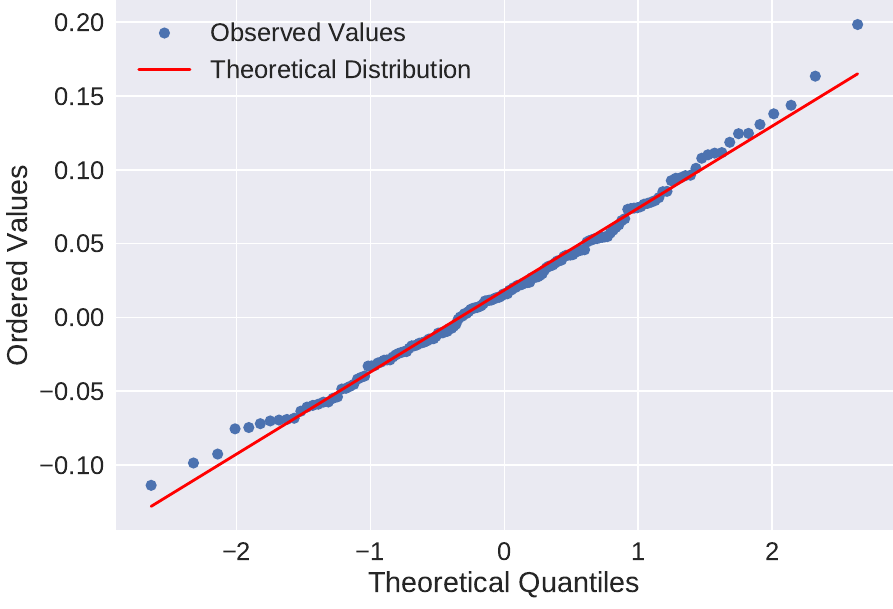
Figure 20. Variables distribution for SMAPE < 10%.